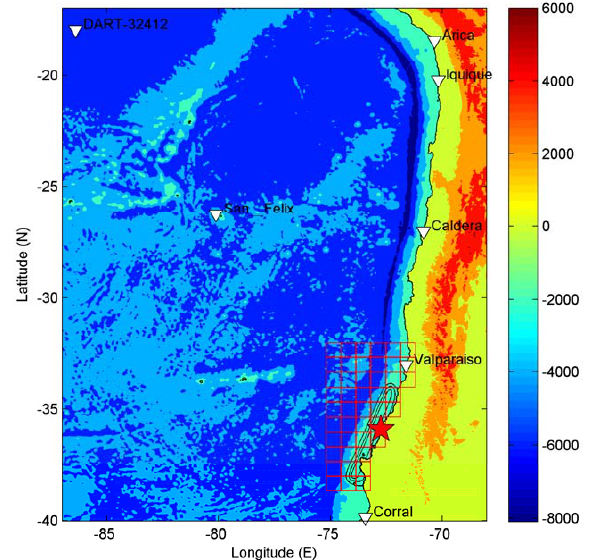
Fig. 6. The computational domain, bathymetry, gauge location (marked in white triangle), epicenter of the 2010 Chile earthquake (marked in red asterisk), tsunami source from Okada model (drawn in contour lines with 1m interval), and the unit sources (drawn in small red squares). The color bar shows the bathymetry in meters.